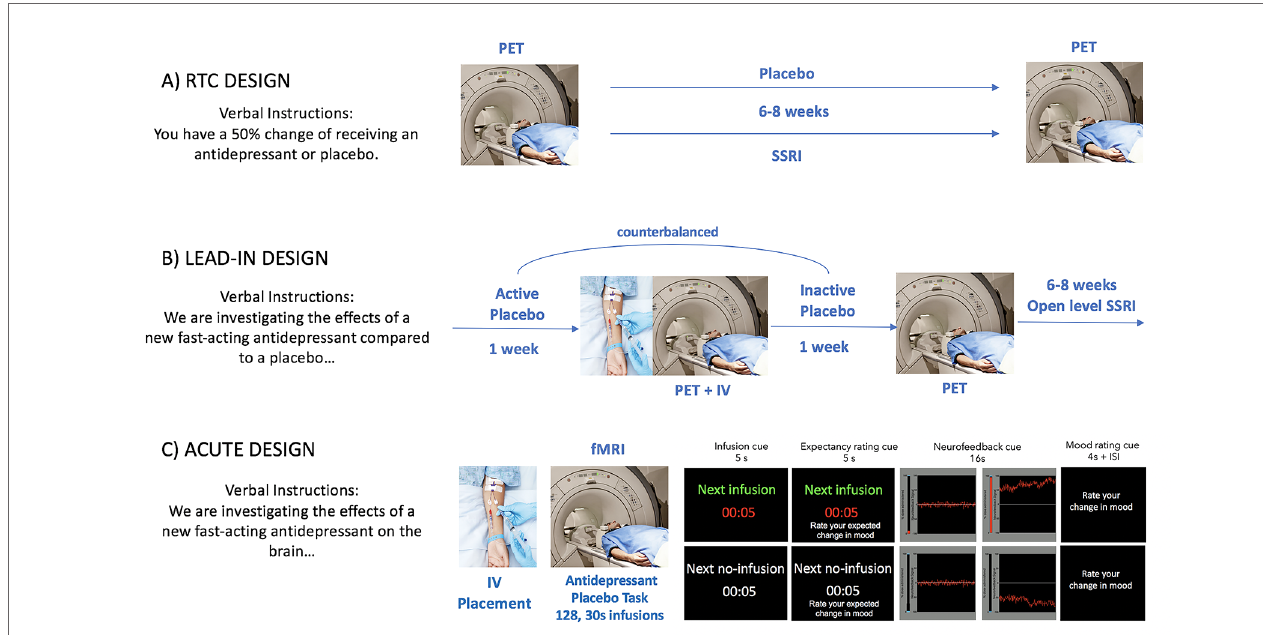
FIGURE 1 | Experimental models of antidepressant placebo effects. Most neuroimaging studies of antidepressant placebo effects fall into one of the following categories: An RCT of active antidepressant vs. placebo, a placebo lead-in phase or an acute placebo